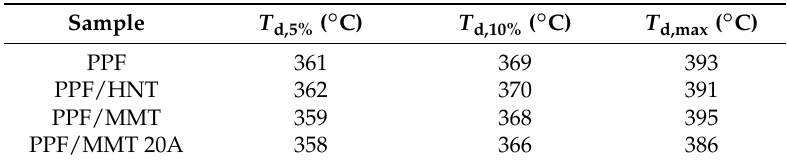
Table 2. TGA results of all the studied